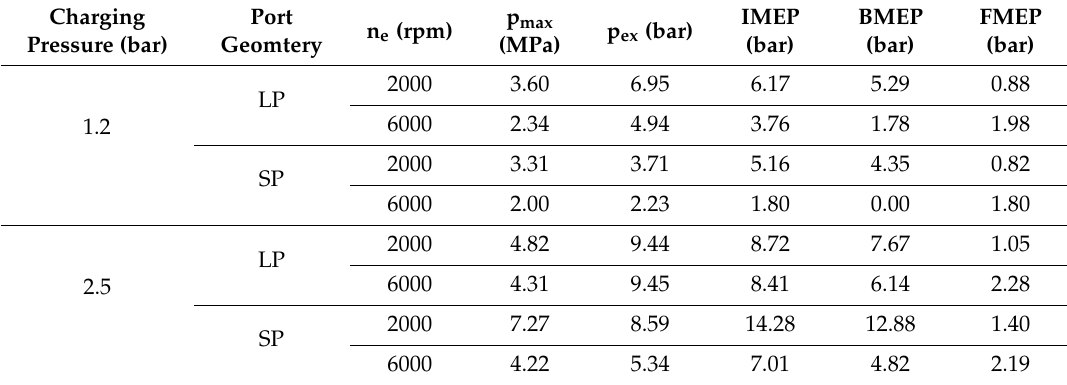
Figure 9. Indicated pressures for LP and SP configurations at various charging pressure and speeds. Table 4. Indicated, e ff ective, and frictional parameters for LP and SP configuration at four di ff erent conditions (best points of indicated mean e ff ective pressure are marked